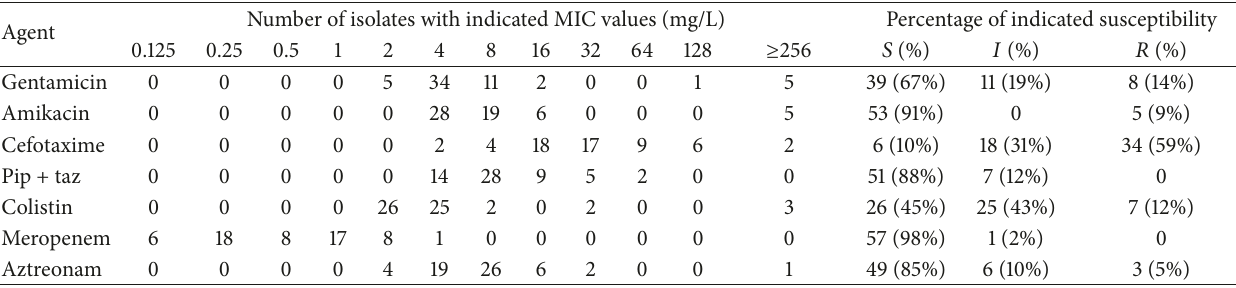
Table 2: Distribution of MICs and antimicrobial sensitivity test of gentamicin, amikacin, cefotaxime, piperacillin/tazobactam, colistin, mero- penem, and aztreonam for P. aeruginosa